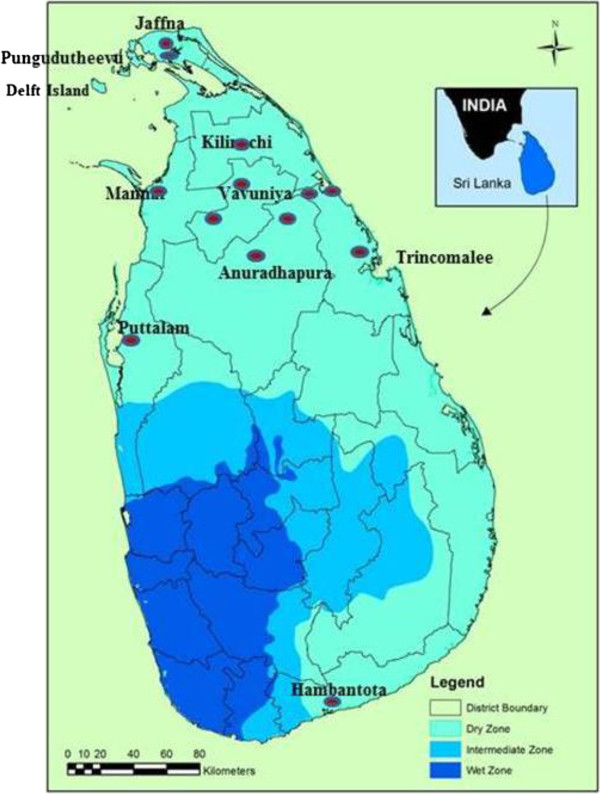
Sampling locations (marked with spots) in several districts of Sri Lanka.